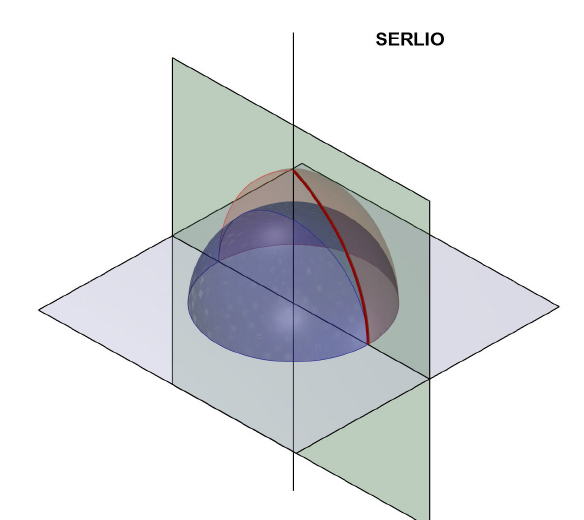
Figure 13. Napoli, S. Maria di Costantinopoli Church: overlap to Vittone